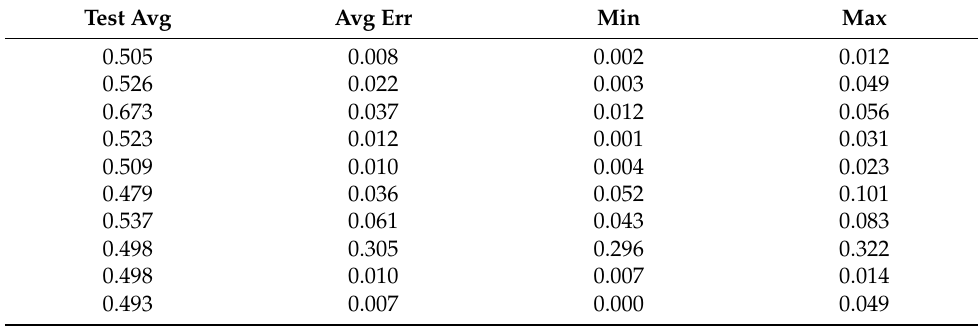
Table A86. Set 2, trials 1–10 data (average actual PR values).